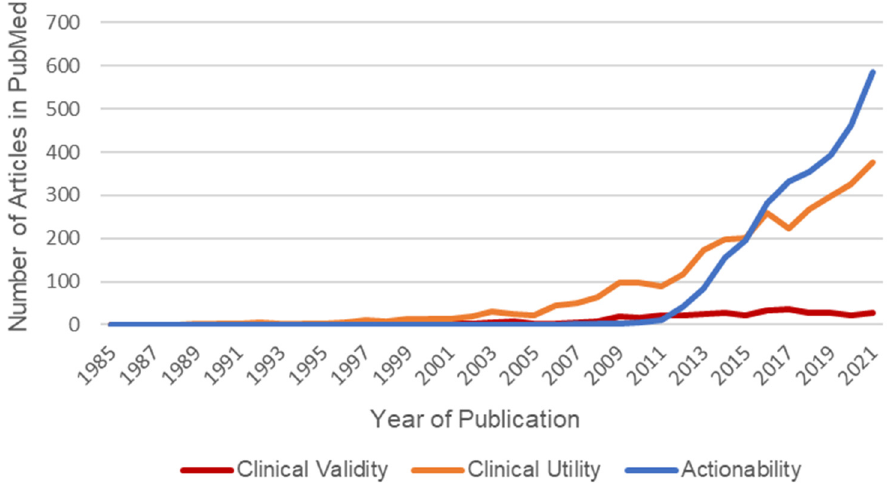
Figure 1. Published genetics articles referencing clinical validity, versus clinical utility, versus ac- tionability. Based on data from three PubMed searches of titles/abstracts: (1) “clinical validity” AND (genetic OR genomic); (2) “clinical utility” AND (genetic OR genomic); (3) (“actionable” OR “actionability”) AND (genetic OR genomic).